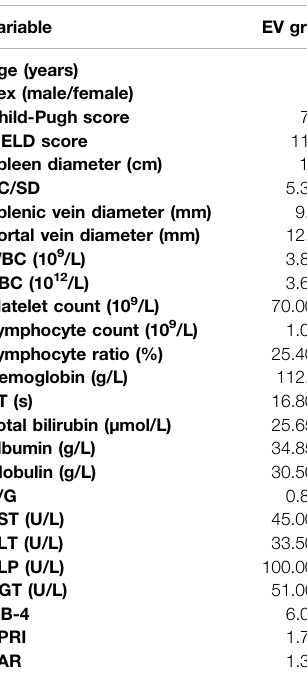
TABLE 2 | Univariate and multivariate analysis of variables according to the presence of EVs.